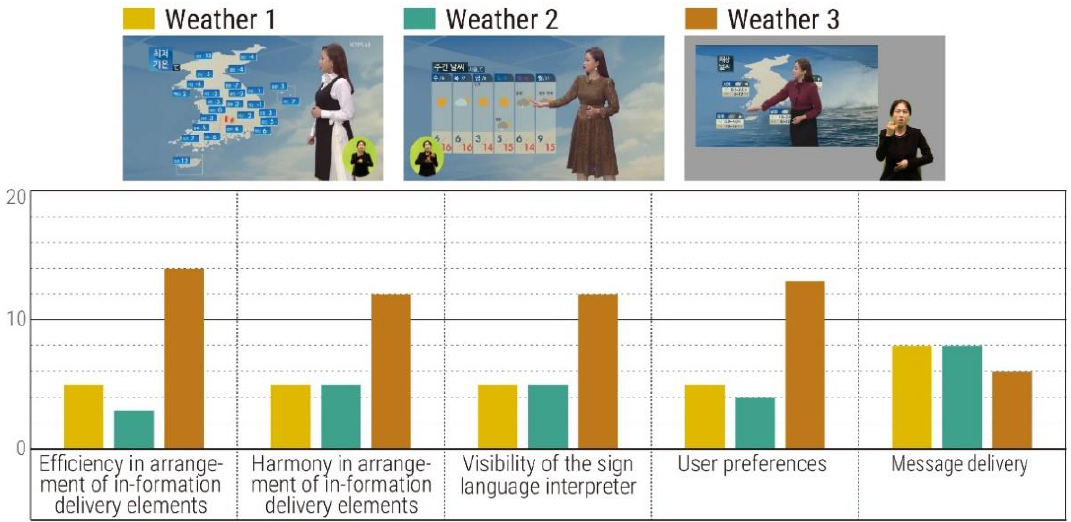
Figure 16. Results of experiments in weather forecast cases.